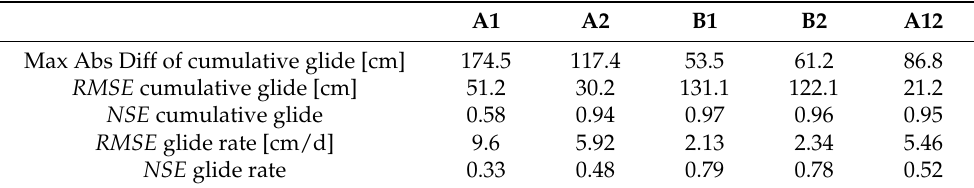
Table 3. Goodness of fit statistics for snow glide, rate, and cumulative glide for each of the 4 glide shoes (A1, A2, B1, B2) and the virtual one